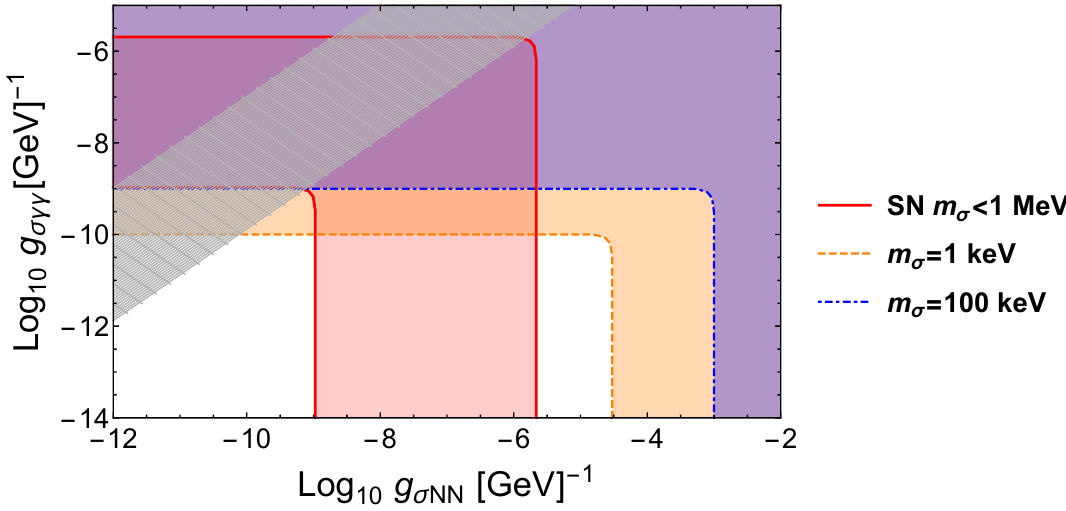
Figure 8. Exclusion region by HB in the g (cid:27)(cid:13)(cid:13) (cid:0) g (cid:27)NN space on the top of SN 1987a limit for m (cid:27) < 1 MeV. The bound on g (cid:27)(cid:13)(cid:13) are obtained approximately from (cid:12)gure 1. In the case g (cid:27)(cid:13)(cid:13) gives dominant contribution to g (cid:27)NN the relation, (4.31) is plotted for 0 : 01 < j b EM grey